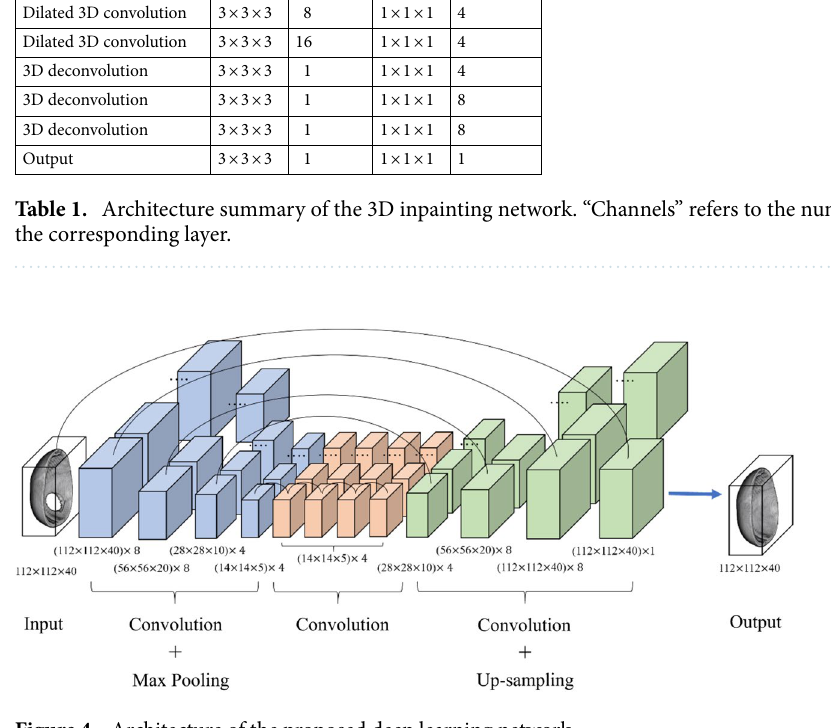
Figure 4. Architecture of the proposed deep learning